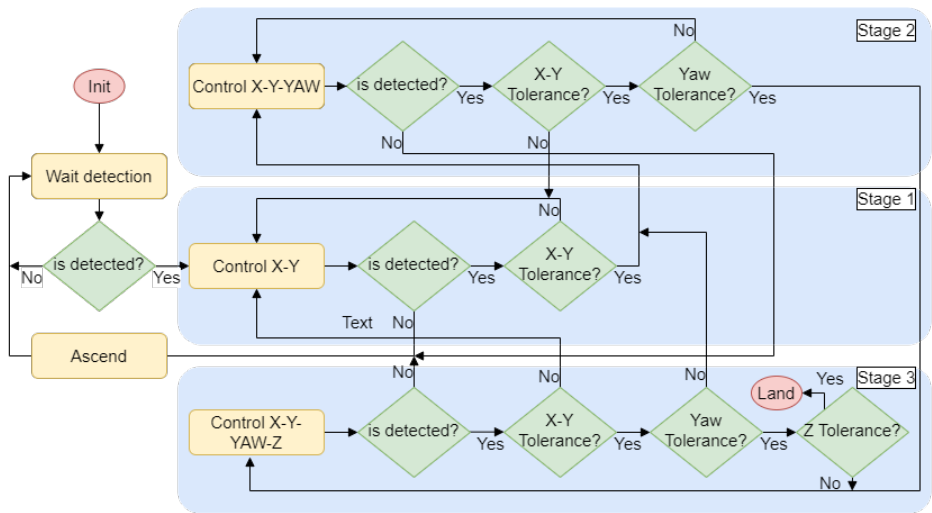
Figure 10. State machine used for the descent and landing